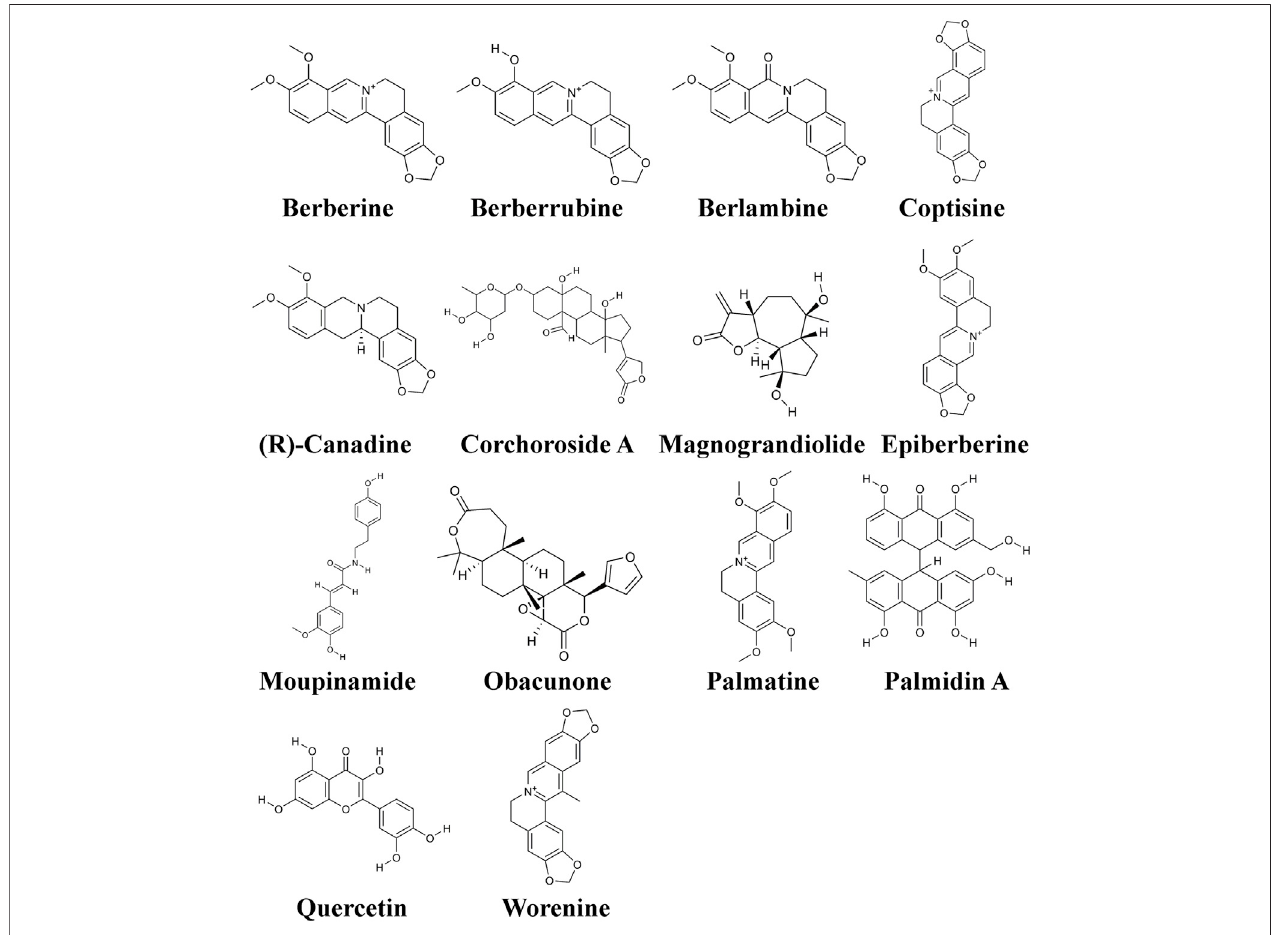
FIGURE 2 | Structures of the 19 active ingredients in